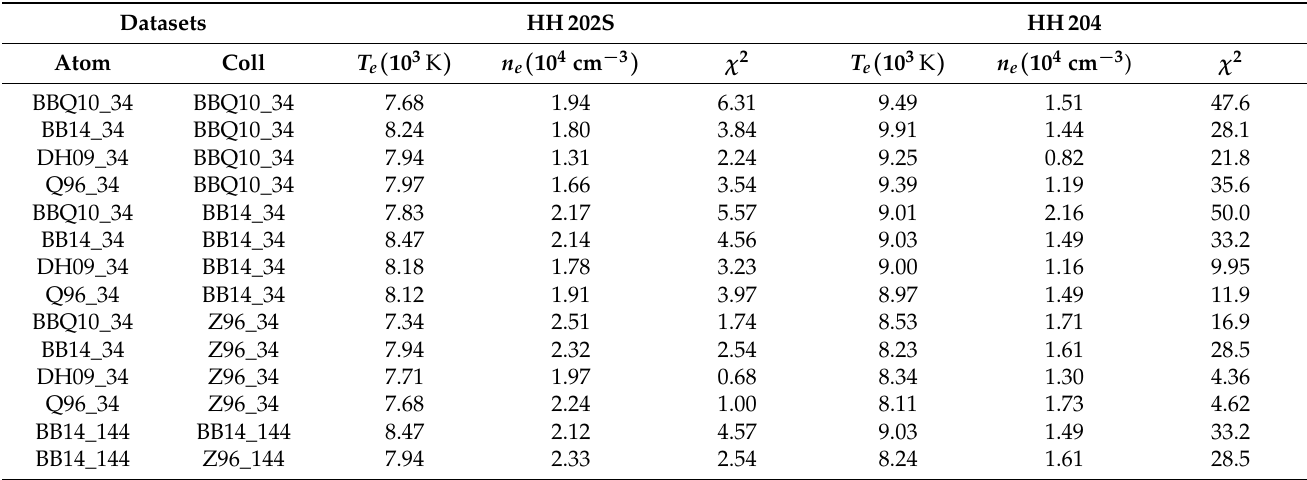
Table 5. Temperature and density fits of the [Fe III ] observed spectra in HH202S and HH204 with the improved or new radiative ( atom ) and collisional ( coll )